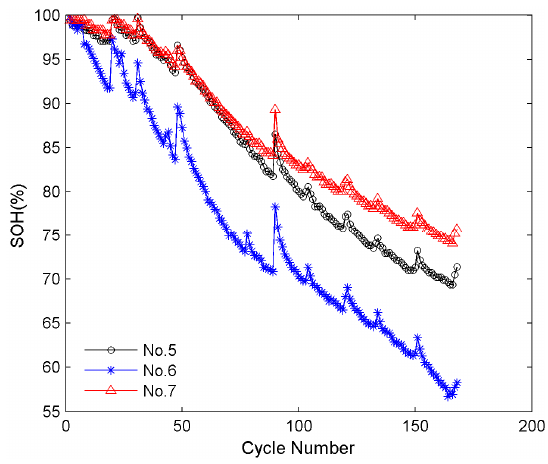
Figure 6. State of Health (SOH) values of batteries Nos. 5, 6 and 7.